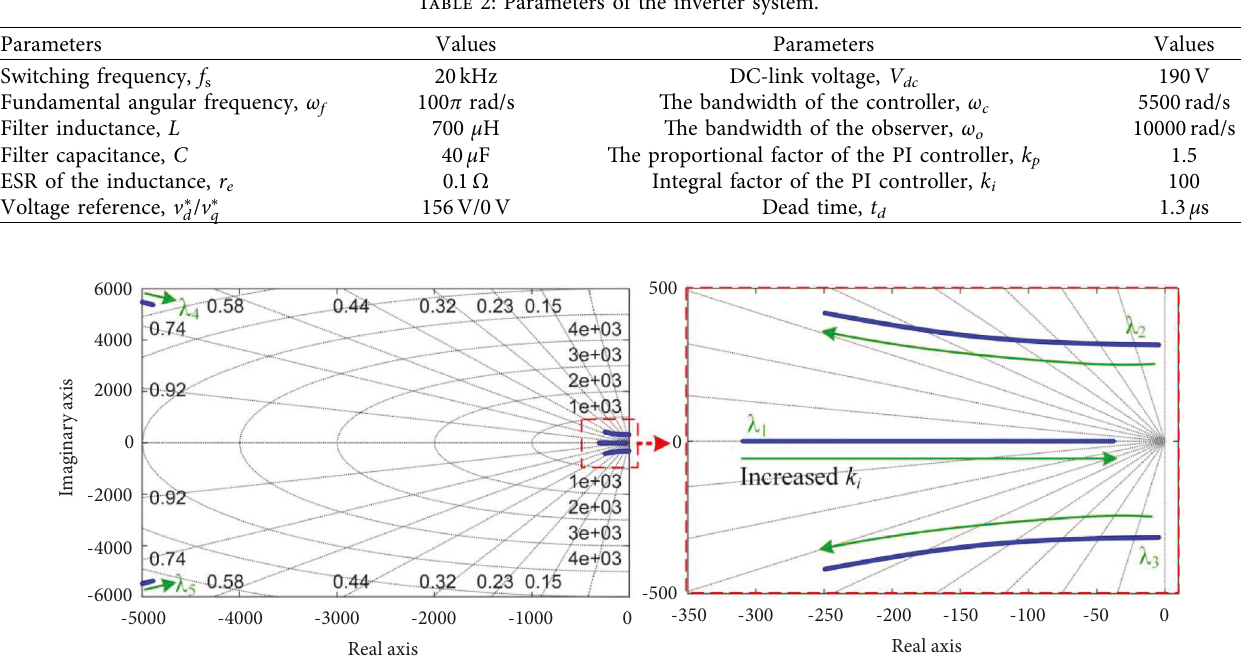
� 1.5, and ω � 5500rad/s). i (10 ≤ ki ≤ 500, k p c